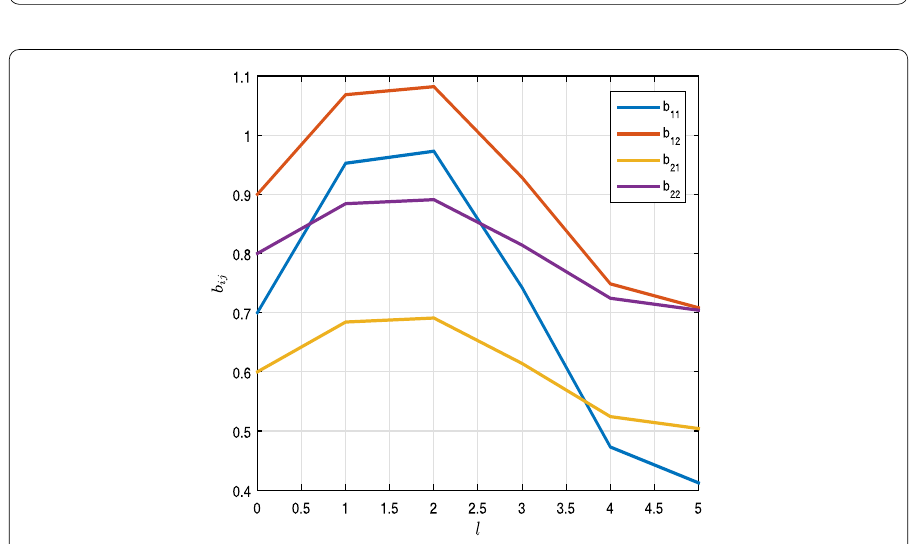
Figure 1 Graphics of a ij , i , j = 1,2, in Example 1